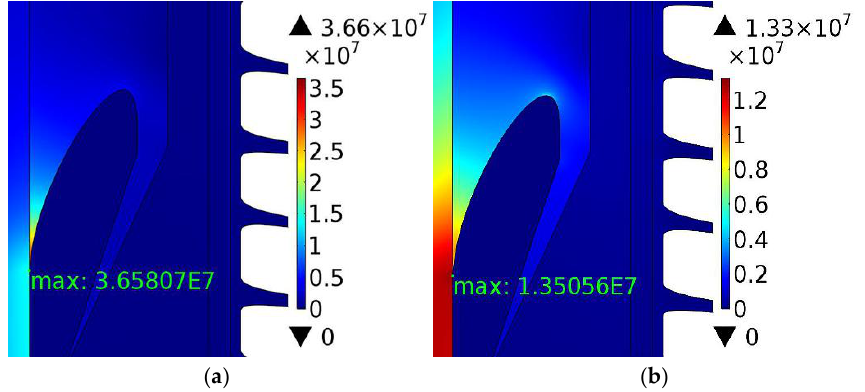
Figure 11. Cable termination simulation results: ( a ) The simulation results of EPDM; ( b ) the simulation results of 8 vol. % CCTO/EPDM.